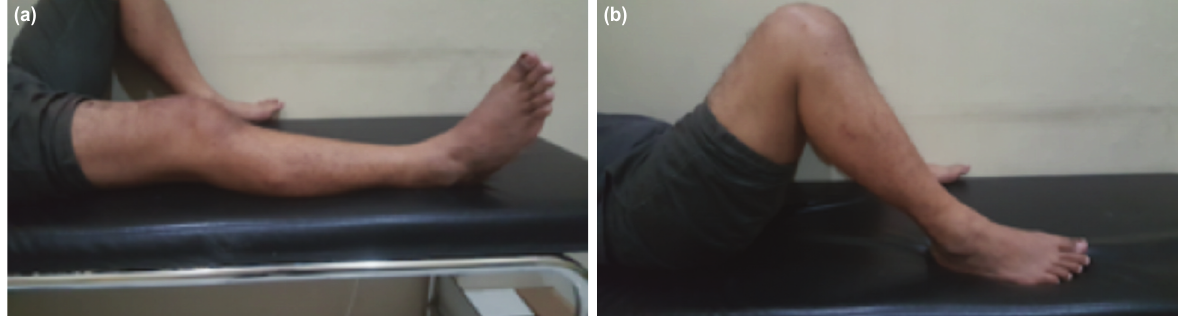
Clinical examination after surgery, (a) maximal extension, (b) maximal Fig. 3: